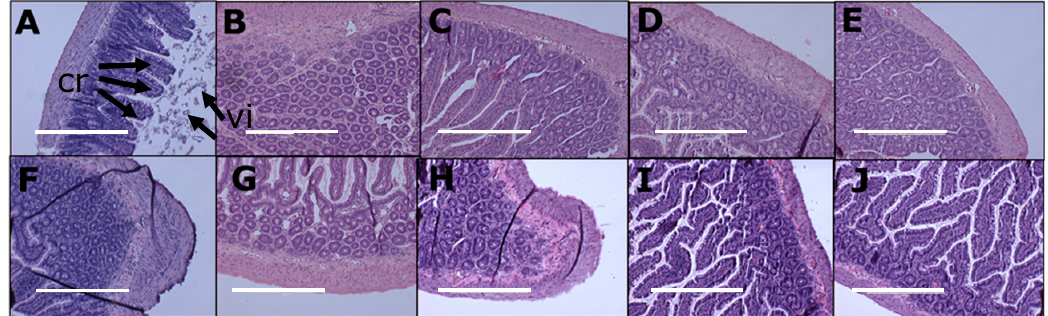
Figure 4. Effects of curcumin on structure, crypt depth (“cr”) and villi length (“vi”) in the ileum using haematoxylin and eosin stain in corn starch diet-fed rats (A), corn starch diet-fed rats given 5 mg/kg/day curcumin (B), corn starch diet-fed rats given 100 mg/kg/day curcumin (C), corn starch diet-fed rats given 5 mg/kg/day curcumin nanoparticles (D), corn starch diet-fed rats given blank nanoparticles (E), high-carbohydrate, high-fat diet-fed rats (F), high-carbohydrate, high-fat diet-fed rats given 5 mg/kg/day curcumin (G), high-carbohydrate, high-fat diet-fed rats given 100 mg/kg/day curcumin (H), high-carbohydrate, high-fat diet-fed rats given 5 mg/kg/day curcumin nanoparticles (I) and high-carbohydrate, high-fat diet-fed rats given blank nanoparticles (J). The white bar is 200 μ m.